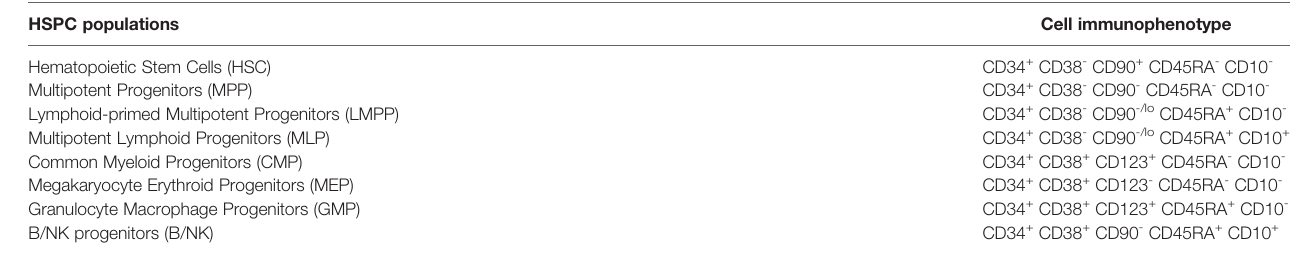
TABLE 2 | HSPC populations and their immunophenotype. HSPC populations Hematopoietic Stem Cells (HSC) Multipotent Progenitors (MPP)